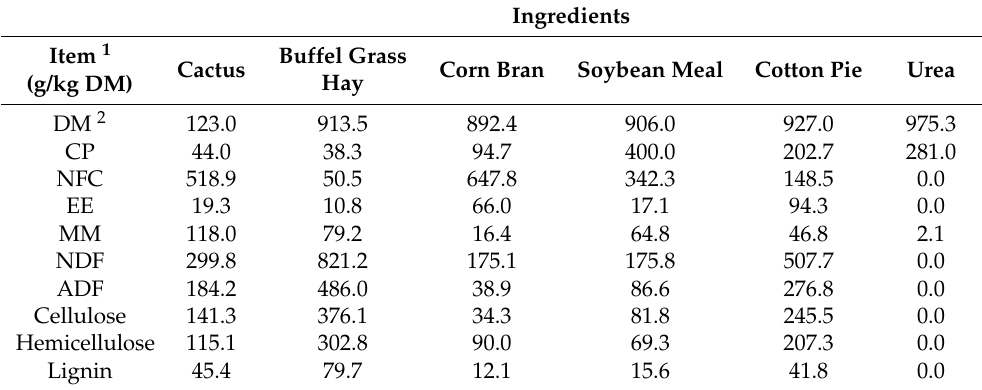
Table 1. Chemical composition of ingredients used in the experimental diets on a dry matter basis.